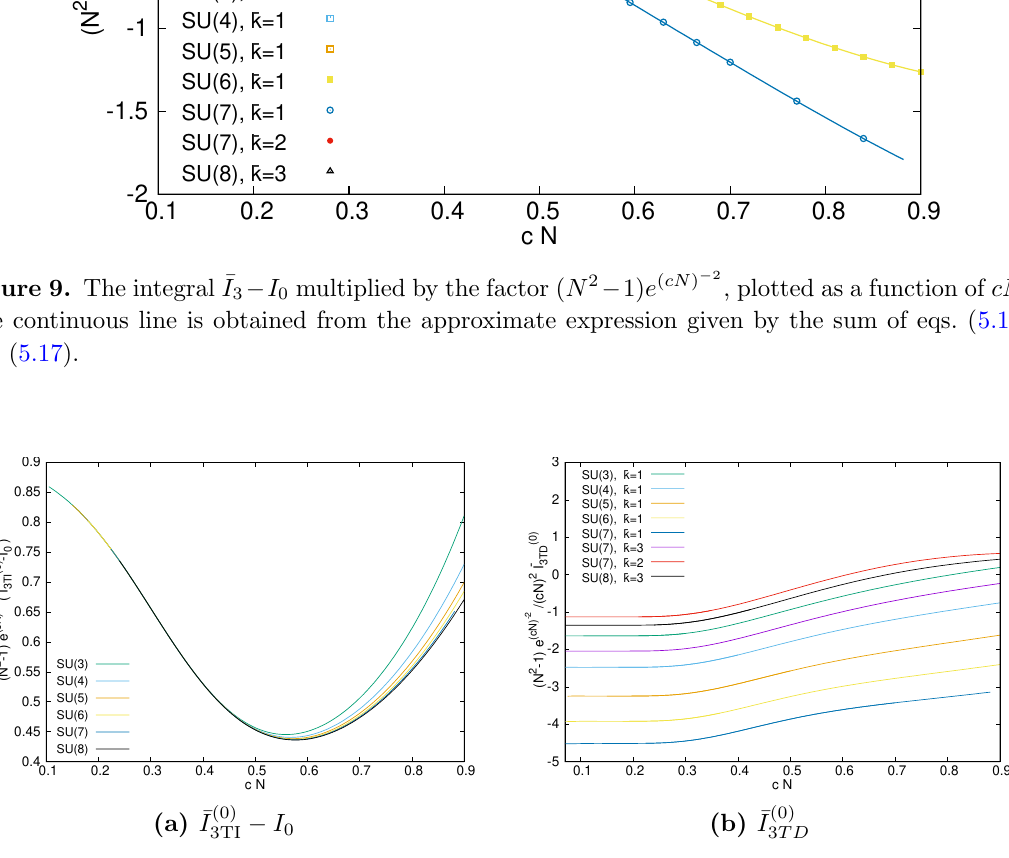
Figure 10. The leading contributions to (cid:22) I 3 from eqs. (5.16) and (5.17), multiplied by factors ( N 2 (cid:0) 1) e ( cN ) (cid:0) 2 and ( N 2 (cid:0) 1) e ( cN ) (cid:0) 2 = ( cN ) 2 respectively and displayed as a function of cN for various values of N and the magnetic (cid:13)ux k